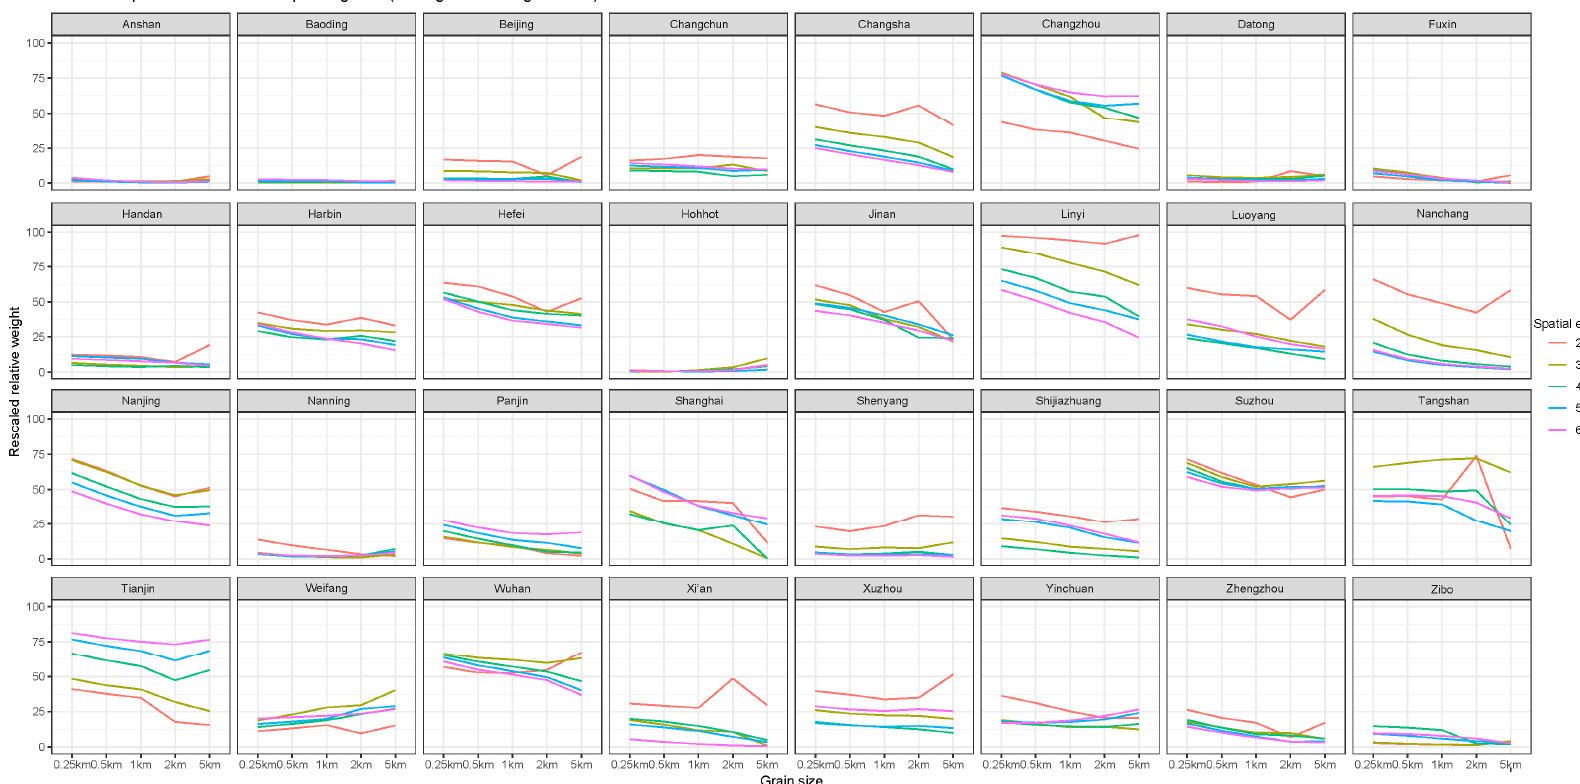
Figure A14. Relative importance of WC for explaning LST(Scalogram of the grain size).